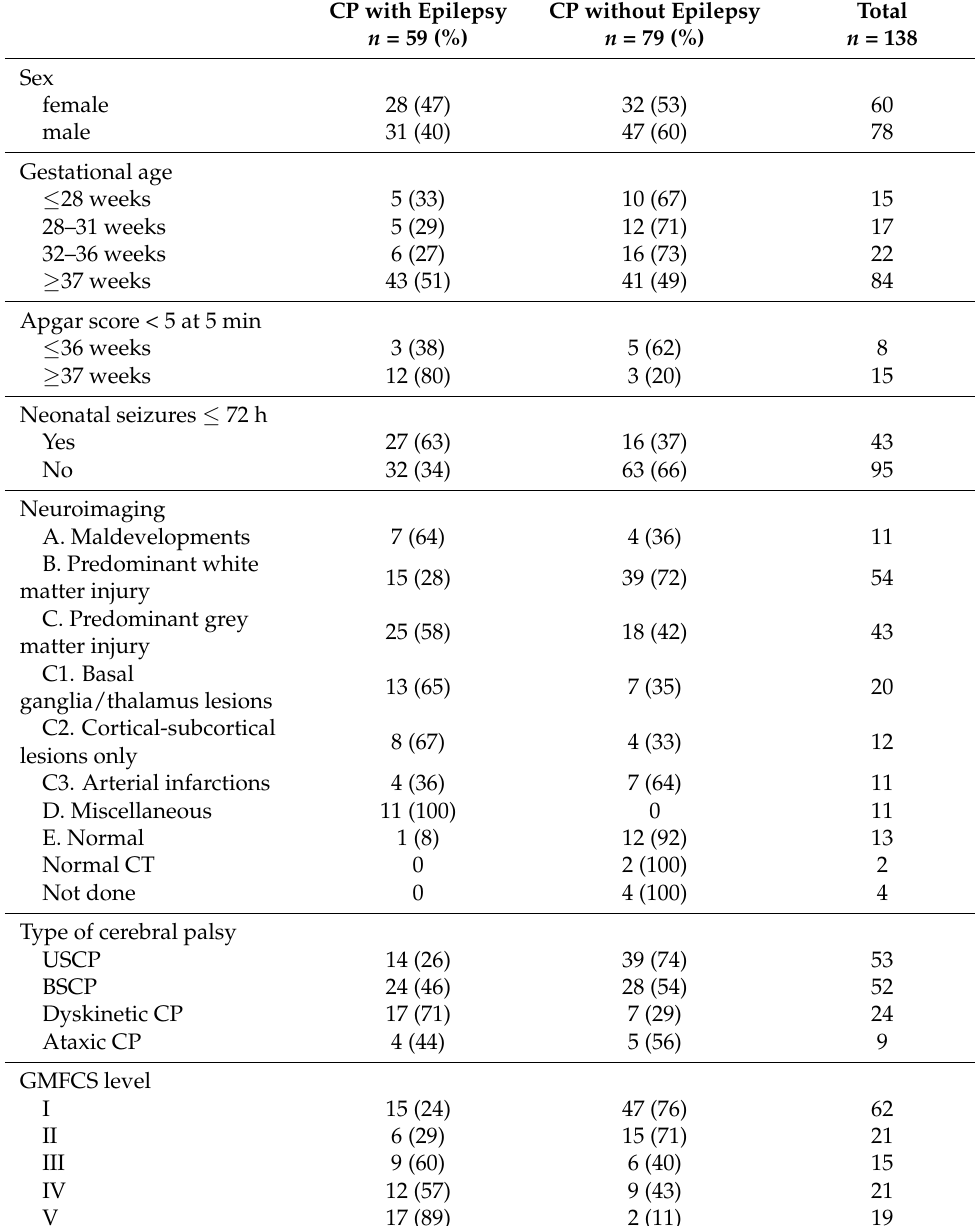
Table 1. Characteristics of children with cerebral palsy (CP) with and without